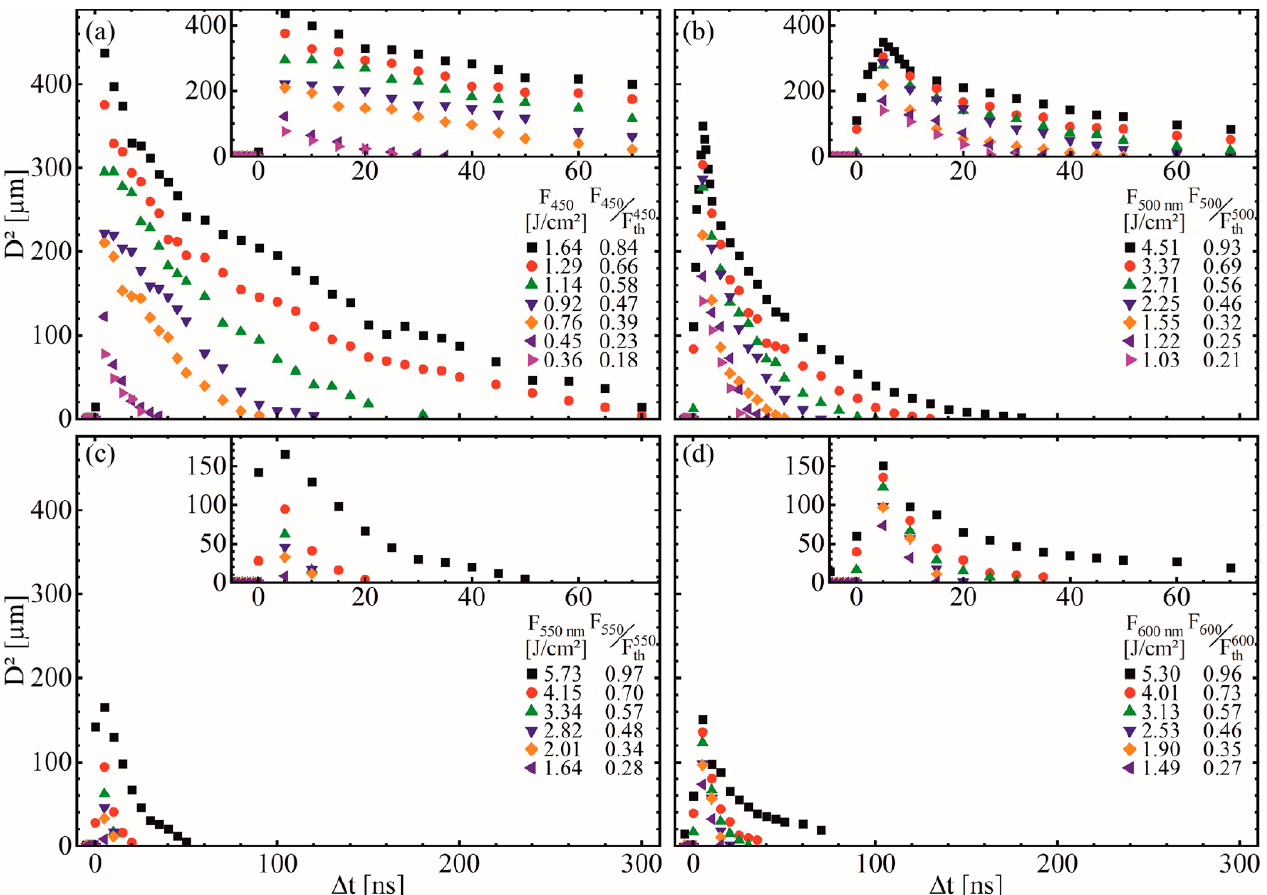
Figure 5. D 2 plotted versus ∆ t to determine the optimal delay between the pulses. For excitation, F pump = 0.2 J/cm 2 was used at ( a ) λ ESA = 450 nm, ( b ) λ ESA = 500 nm, ( c ) λ ESA = 550 nm, ( d ) λ ESA = 600 nm. F ESA was varied in the identical increments as for Figure 3b (color coded with F ESA and the F ESA /F th -ratio). In the top-right corners, the section of short ∆ t is extended.